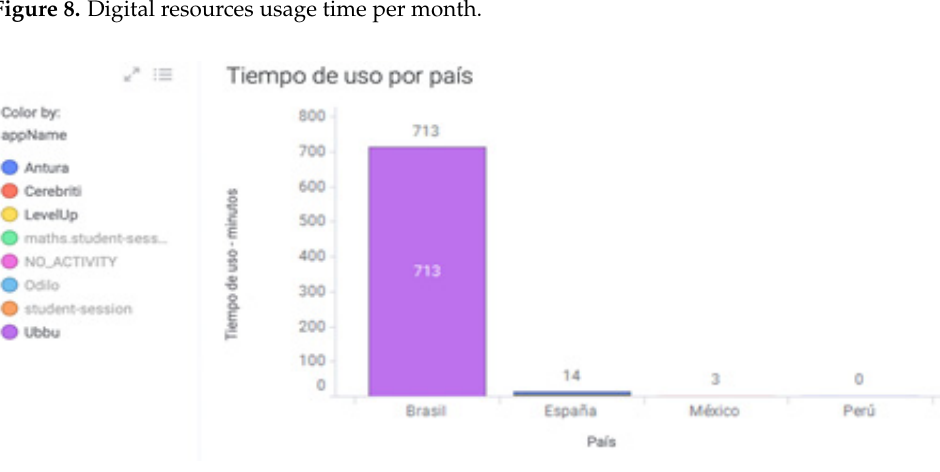
Figure 9. Digital resources usage time per country.